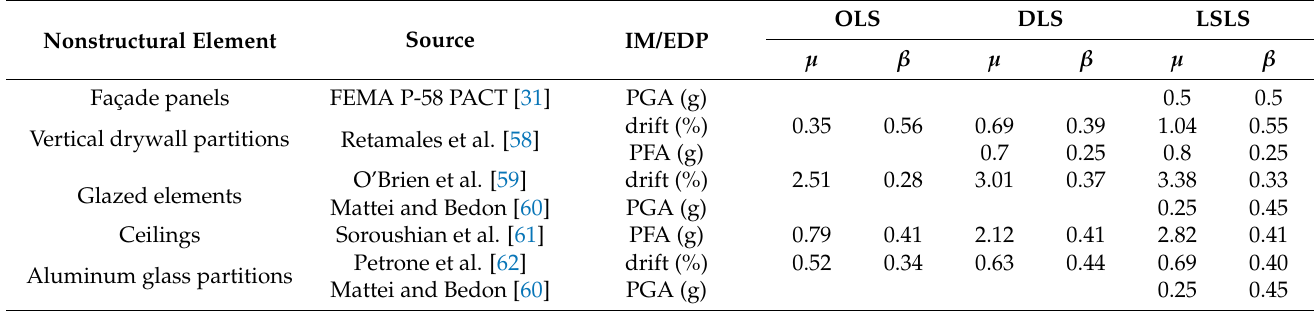
Table 8. Median µ and logarithmic standard deviation β values of the log-normal fragility curves for ARCH nonstructural elements, along with the literature sources.